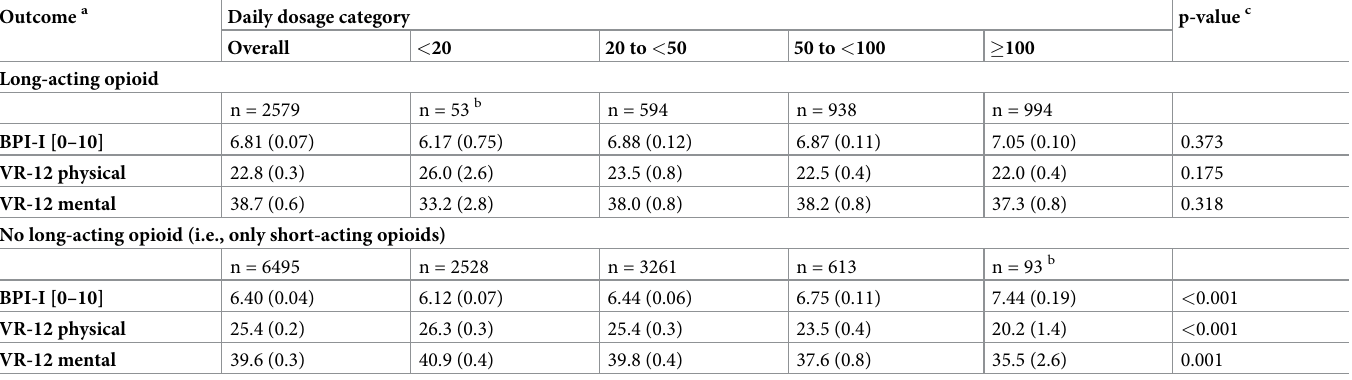
Table 4. Patient-reported outcomes by opioid formulation (long-acting opioid versus no long-acting opioid) and opioid daily dosage category in 6 months before the index date. Outcome